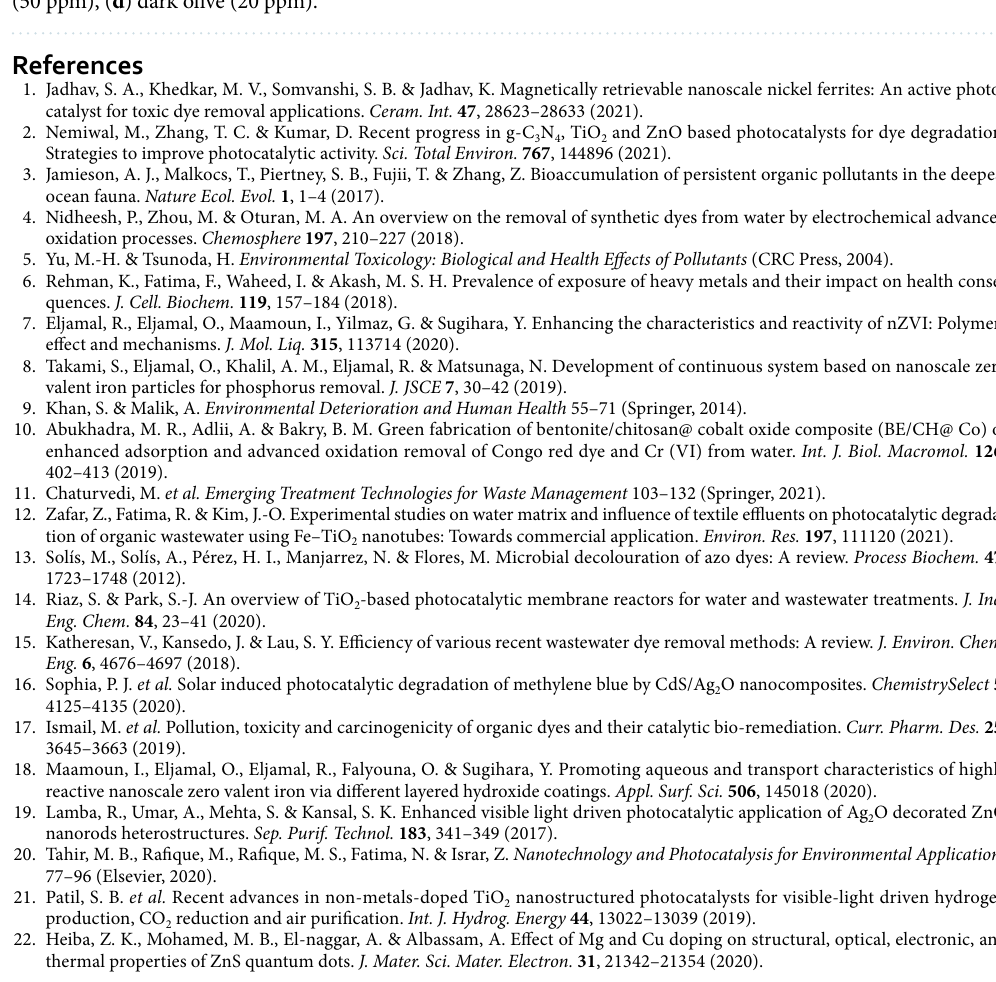
Figure 15. UV–visible spectra for ( a ) pastel pink (15 ppm), ( b ) benton (15 ppm), ( c ) carton wastewater (50 ppm), ( d ) dark olive (20